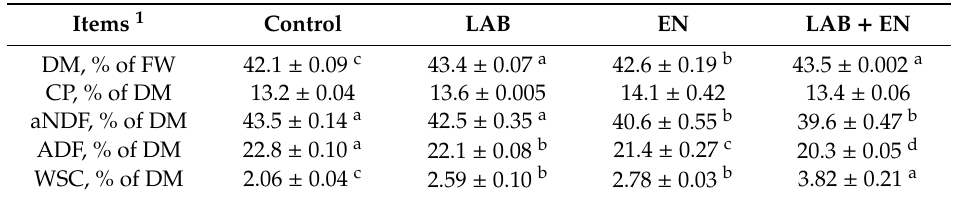
Table 2. E ff ects of lactic acid bacteria and / or fibrolytic enzyme on the chemical composition of total mixed ration silages containing wet corn gluten feed and corn stover. Items